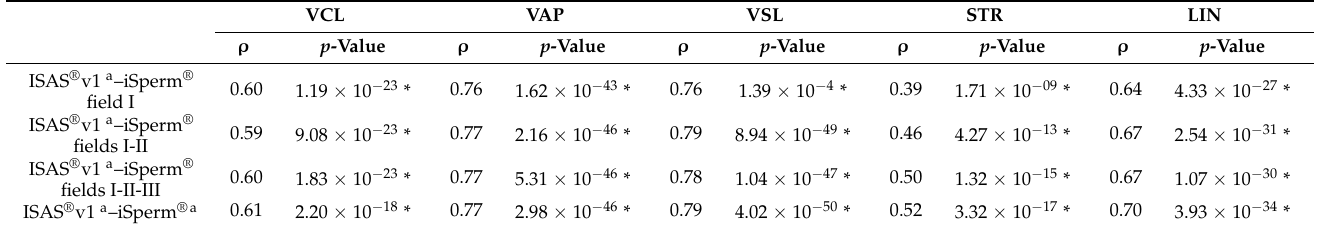
Table 2. Spearman correlation coefficients ( ρ ) between the ISAS ® v1 and different number of fields analyzed by the iSperm ® for some kinematic parameters: curvilinear linear velocity (VCL), average path velocity (VAP), straight line velocity (VSL), straightness (STR), and linearity (LIN). VCL VAP VSL STR LIN